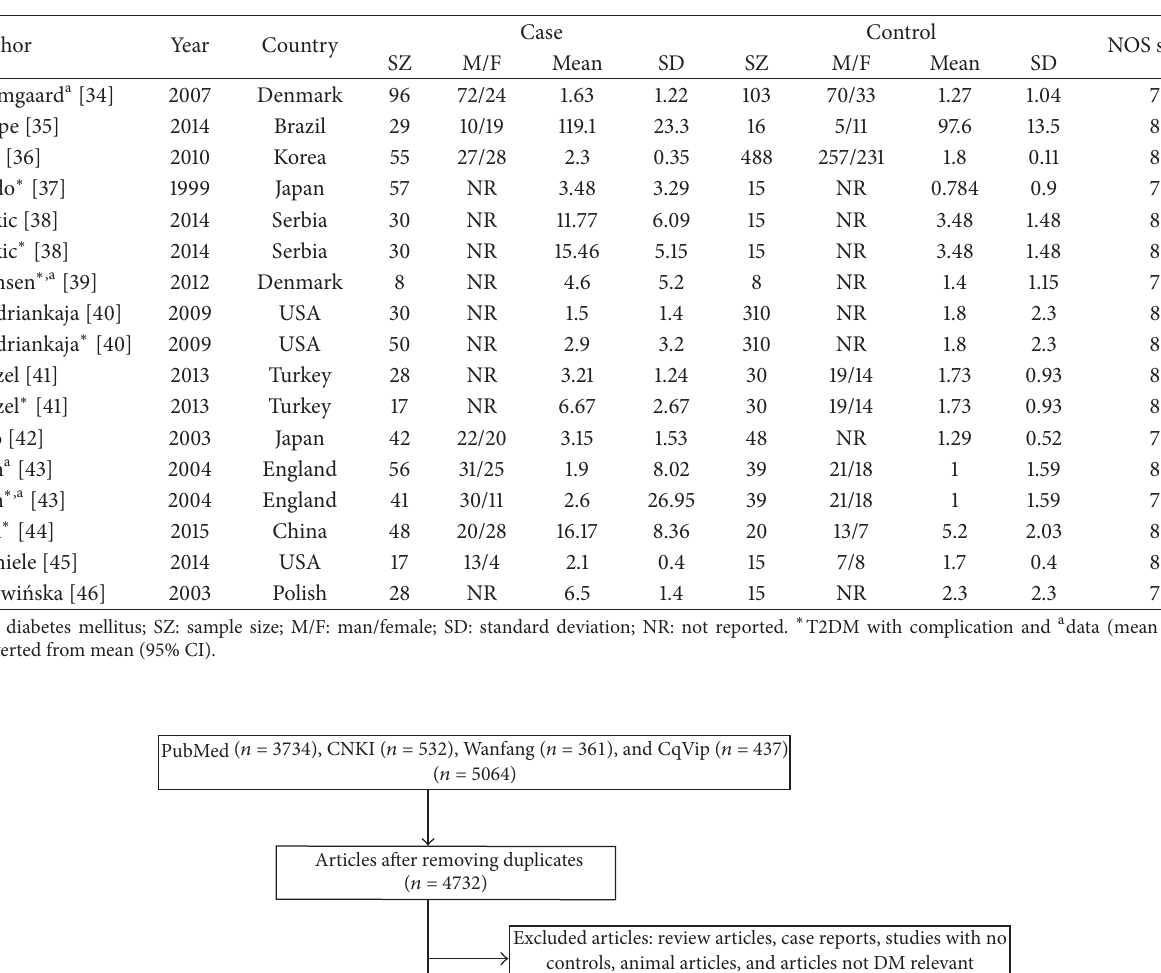
Table 1: Characteristics of studies about IL-6 (pg/mL) included in this meta-analysis.